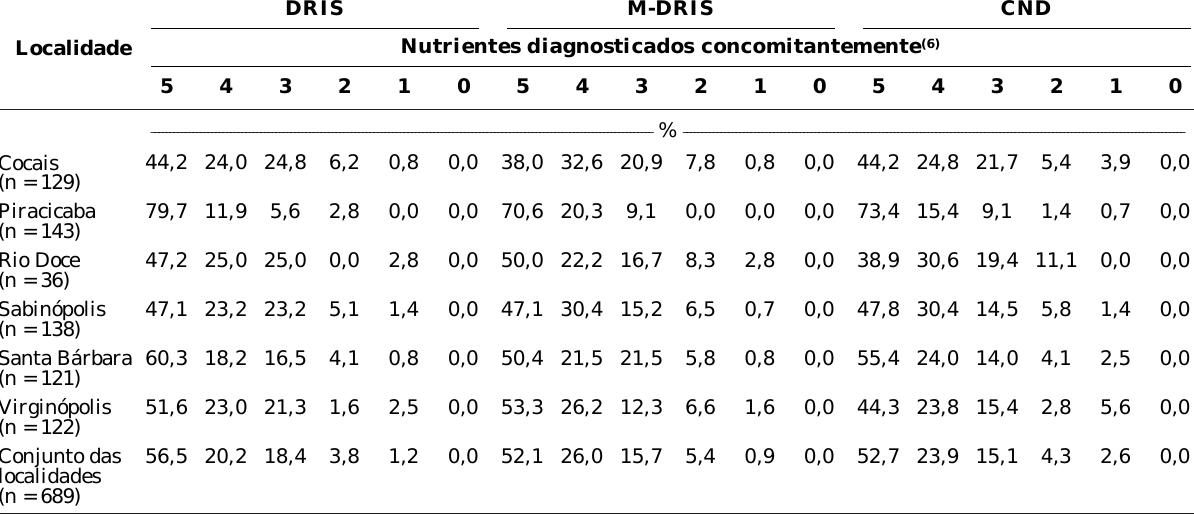
Quadro 4. Freqüência de talhões com diagnoses concordantes do potencial de resposta à adubação (1) para os nutrientes considerados concomitantemente conforme as situações (5, 4, 3, 2, 1 e 0) em Eucalyptus grandis , subpopulação de baixa produtividade (2) , na região Centro-Leste de Minas Gerais, utilizando os métodos DRIS (3) , M-DRIS (4) e CND (5) , mediante normas específicas para cada